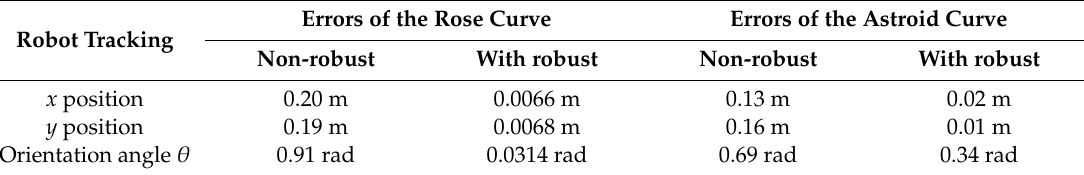
Table 5. Mean of tracking errors (parameters changed).